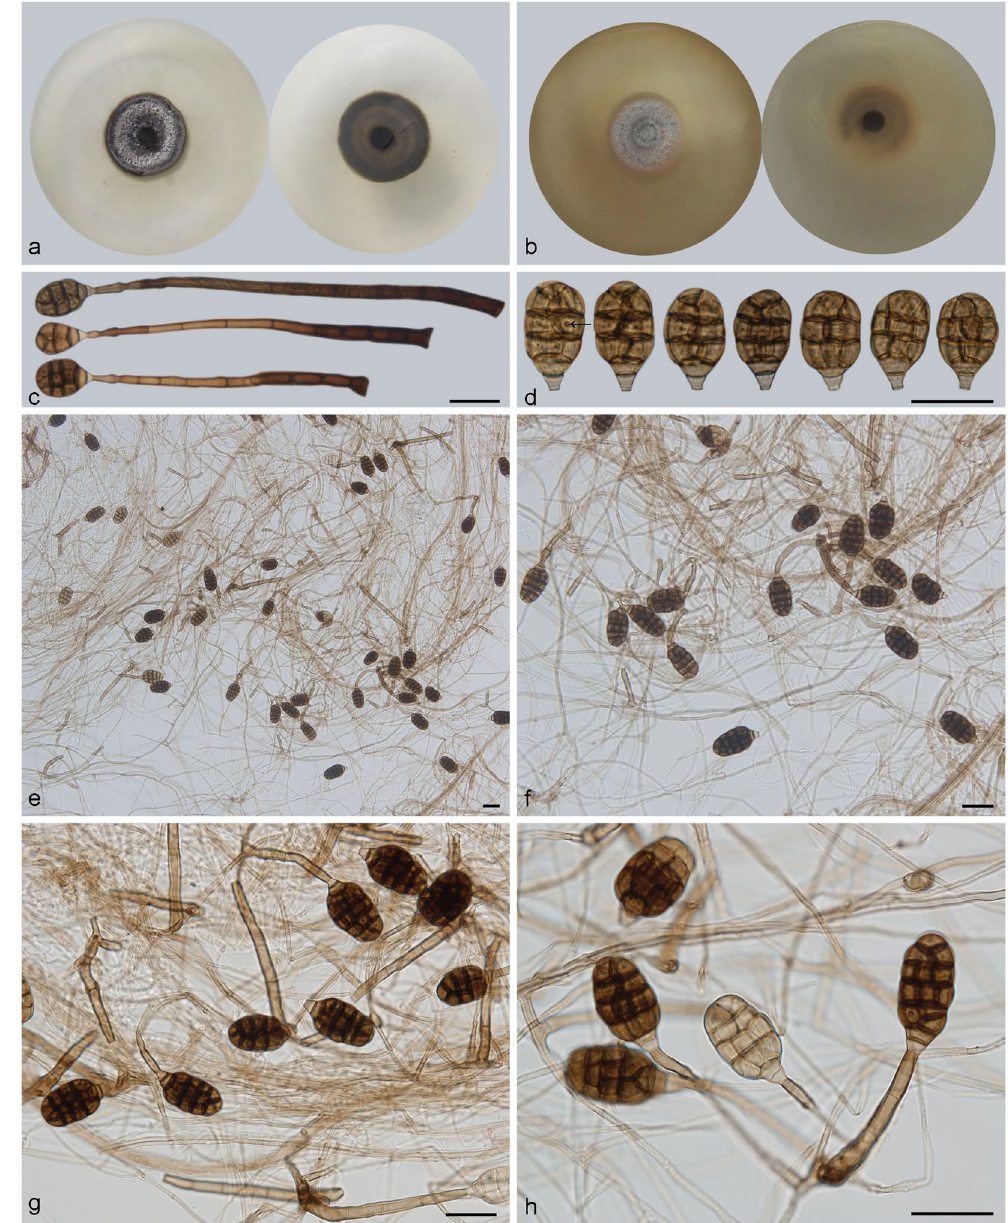
Figure 9. Acrodictys porosiseptata. ( a ) Colony on PDA (surface and reverse). ( b ) Colony on MEA (surface and reverse). ( c , d ) From natural substrate (HSAUP H4698): ( c ) Conidiophores with conidia, ( d ) Conidia. ( e – h ) From PDA (CGMCC 3.18650): Conidiophores and conidia. — Scale bars = 20 μ